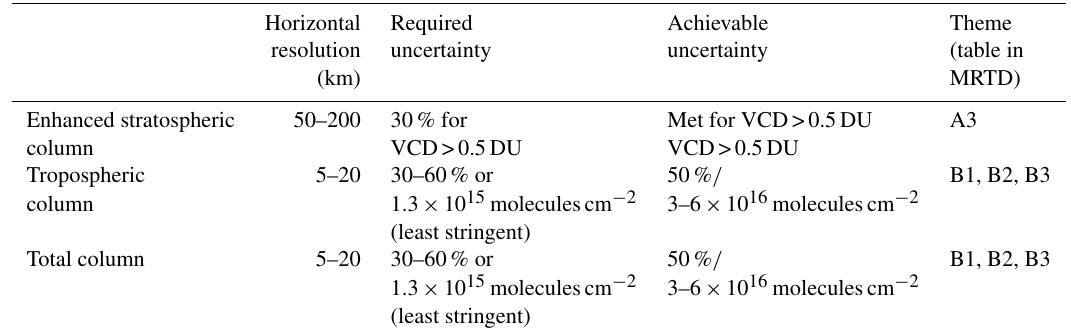
Table 1. Requirements on SO 2 vertical column products as derived from the MRD. Left- and right-hand numbers in ranges denote accuracy and precision, respectively. Horizontal Required Achievable Theme resolution uncertainty uncertainty (table in (km) MRTD) Enhanced stratospheric 50–200 30% for Met for VCD>0.5DU A3 column VCD>0.5DU VCD>0.5DU Tropospheric 5–20 30–60% or B1, B2,